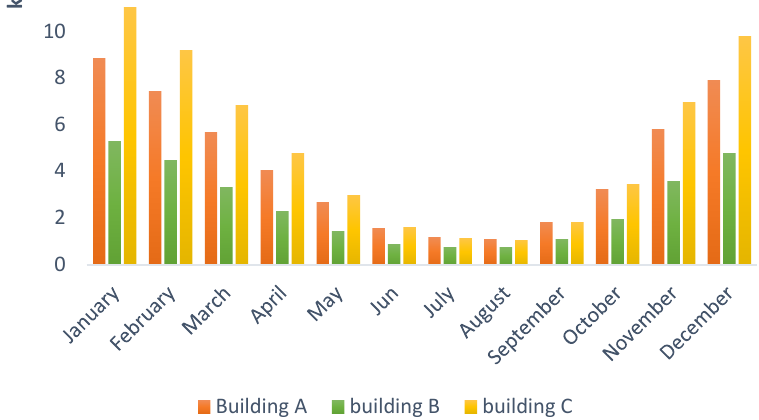
Figure 8. The total hourly heat demand of the group of buildings in a typical year.